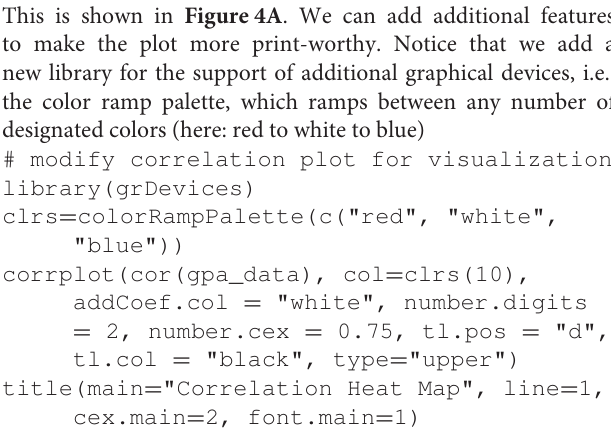
not yield easy visualization, especially if there are many variables being compared simultaneously. We can leverage the corrplot package to facilitate visualization of high- dimensional correlation